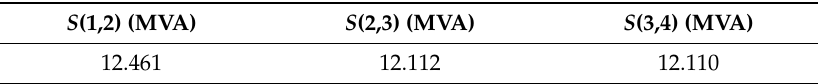
Table A3. Apparent power flow in the 4-bus